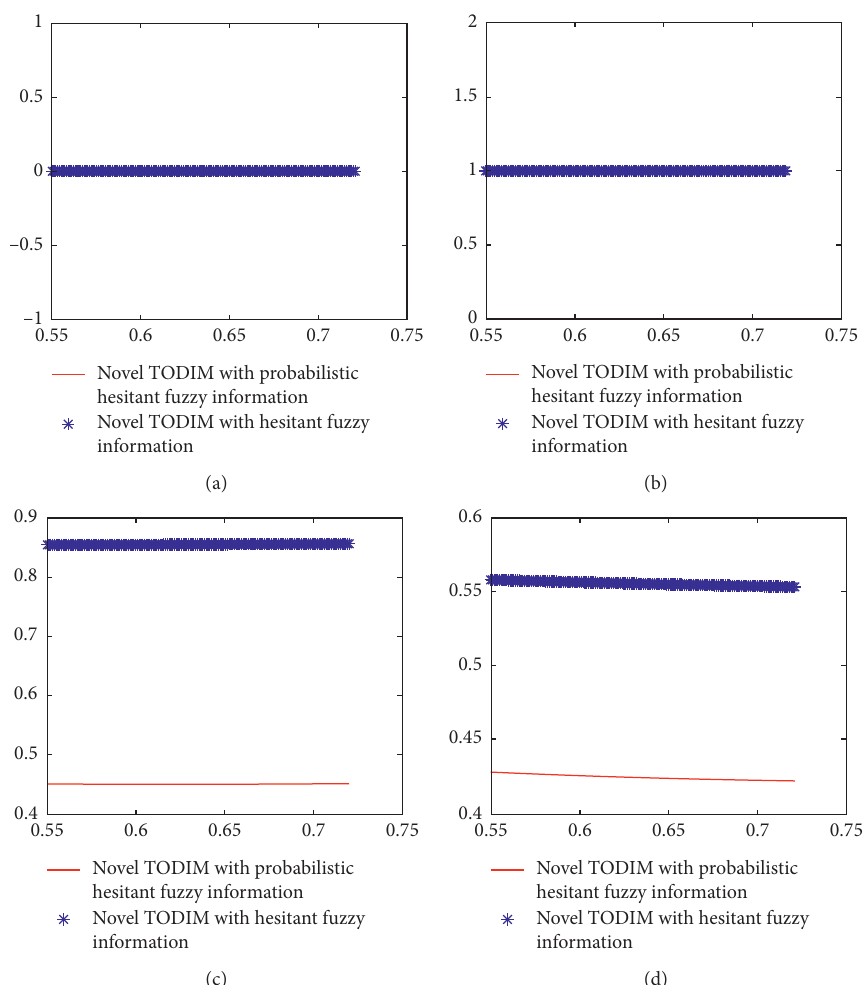
Figure 8: SensitivityanalysisofthenovelTODIMbychanging c .0 . 55 ≤ c ≤ 0 . 721, α � β � 0 . 88, δ � 0 . 69,and λ � 2 . 25.(a) A